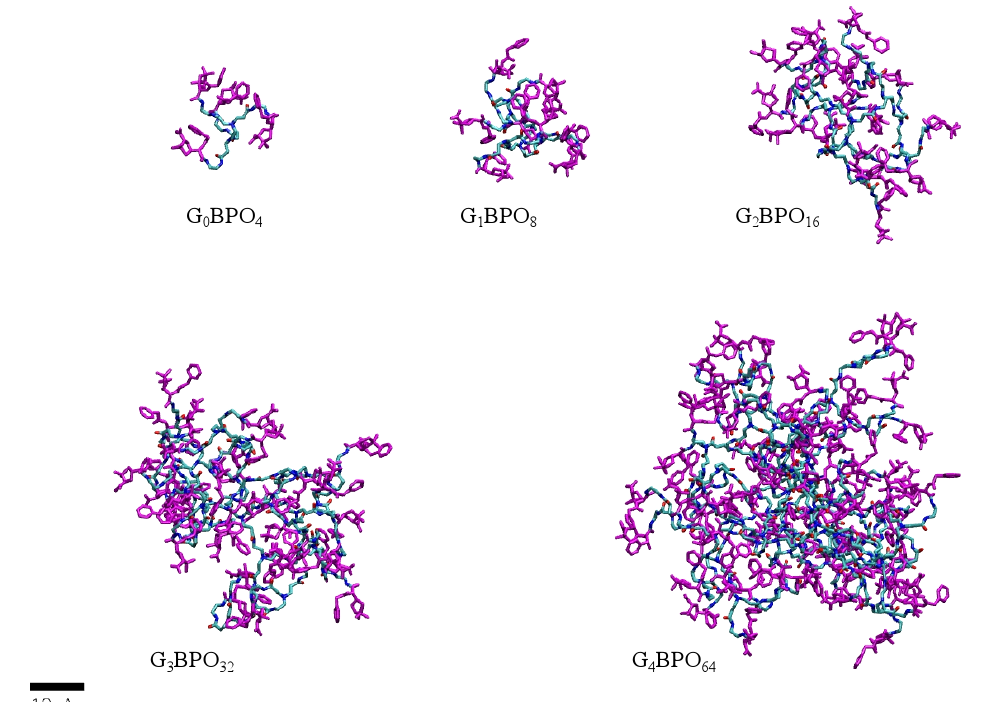
BPO to G BPO dendrimers after MD 0 4 4 64